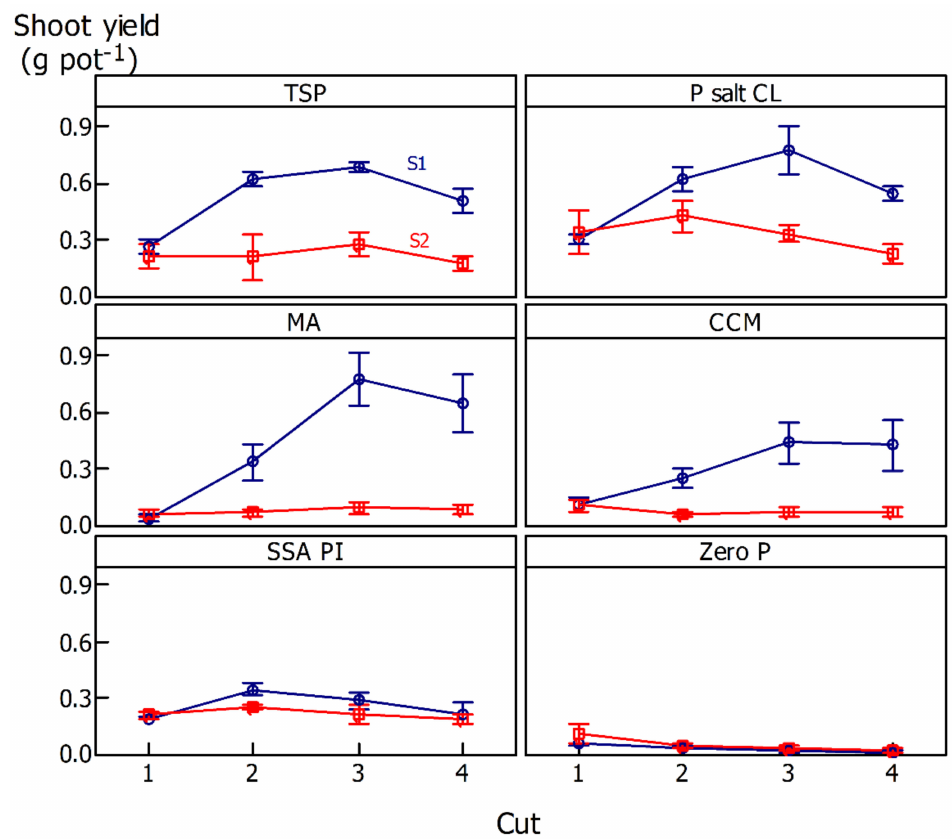
Figure 2. Shoot yield dry wt. (g pot − 1 ) of perennial ryegrass as affected by tested fertilizing products (TSP—triple superphosphate; P salt CL—chemically leached P salt; MA—microalgae; CCM—crab carapace material; SSA PI—sewage sludge ash obtained by pyrolysis and incineration; Zero P—no fertilizing product) in two different substrates (S1—river sand, and S2—artificial mineral substrate) over four months. Shapes present mean values and error bars indicate two standard